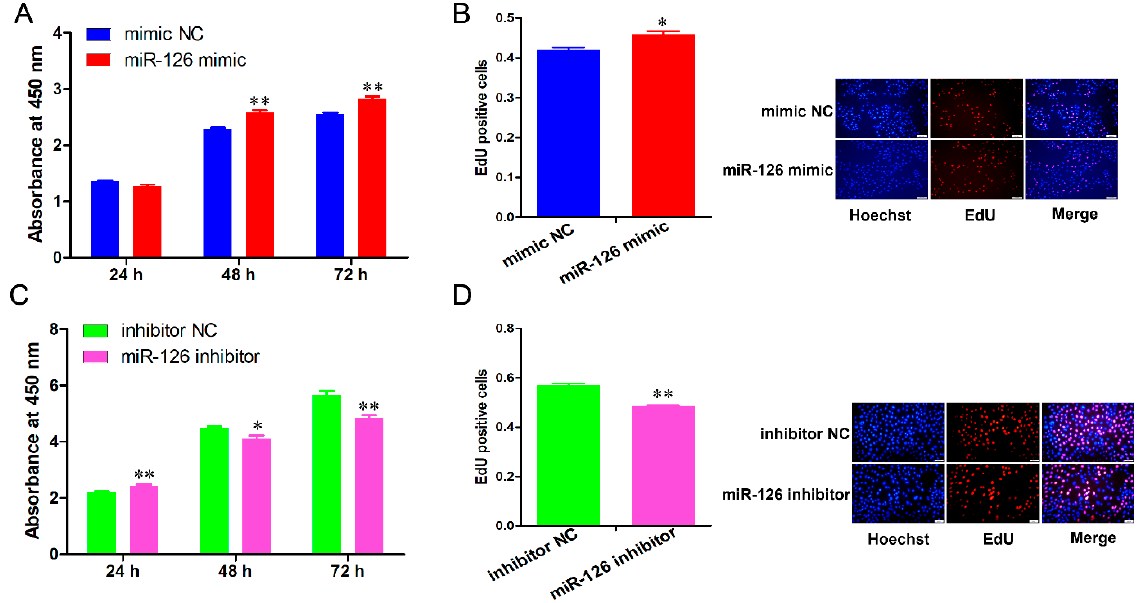
Figure 2. miR-126 enhances immature porcine Sertoli cell proliferation. The immature porcine Sertoli cells were transfected with miR-126 mimic or miR-126 inhibitor. ( A , C ) The effects of miR-126 overexpression ( A ) and miR-126 inhibition ( C ) on cell proliferation were assessed using the CCK-8 assay. The absorbance per sample was detected using an ELISA plate reader (Molecular Devices, San-Jose, CA, USA) at 450 nm ( n = 3). ( B , D ) Results of the analysis of EdU-positive cells ( n = 3). Representative images of immature porcine Sertoli cells showing mitotic activity for EdU staining. Scale bar = 200 µ m. All data are presented as the mean ± SEM, * p < 0.05 and ** p < 0.01.